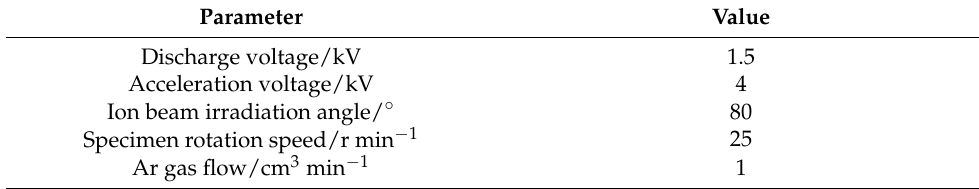
Table 1. The parameters for ion